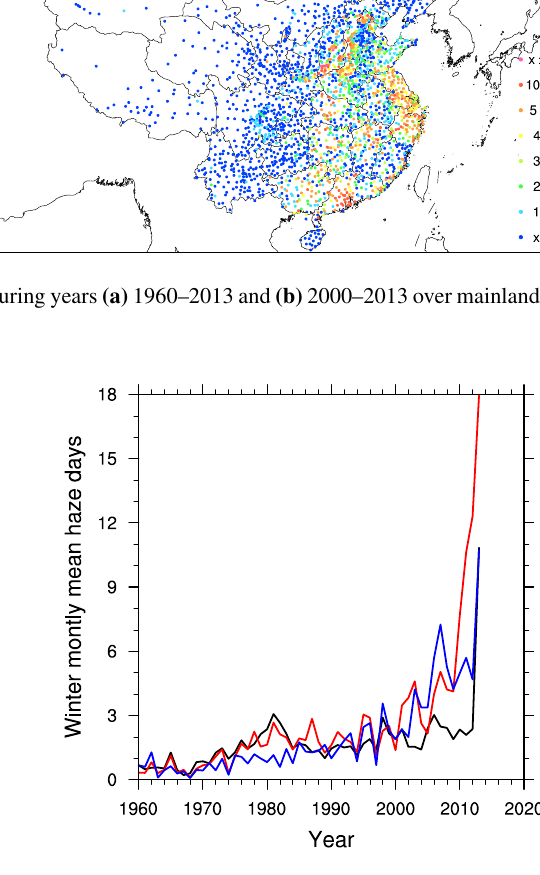
Figure 3. Time series of the winter-average monthly haze days (units: daysmonth − 1 ) of JJJ (black), JZH (red), and GG